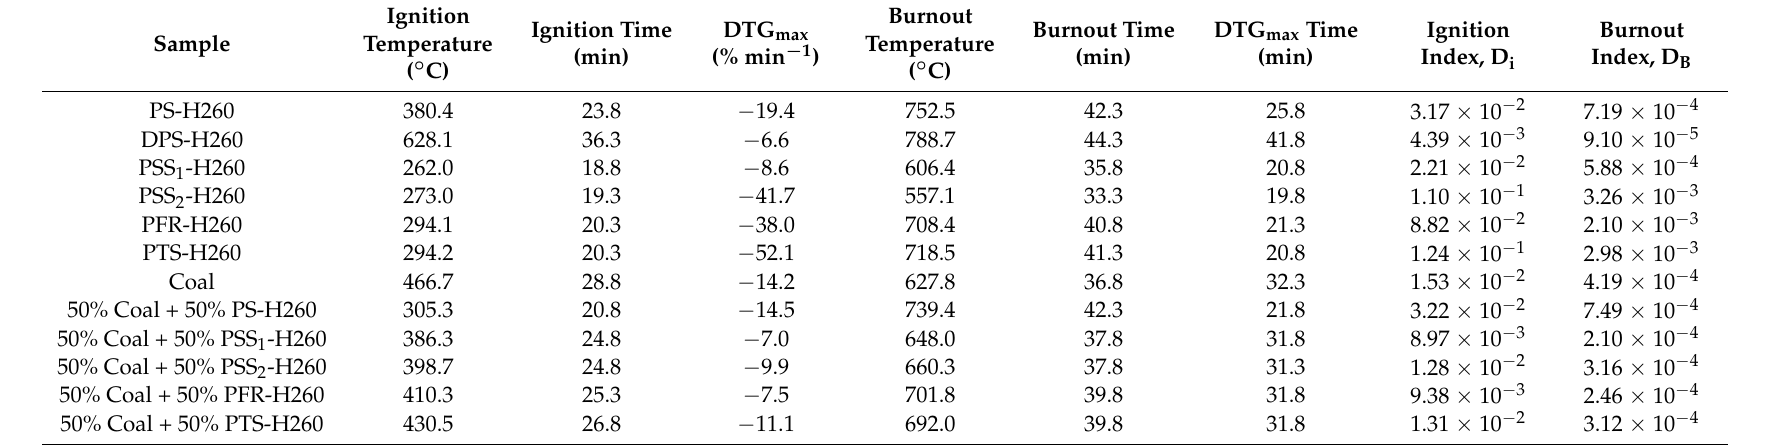
Table 4. Combustion Characteristics of determined from Combustion TGA data. (Clarion #5a coal (bituminous) was used for co-combustion [59]).